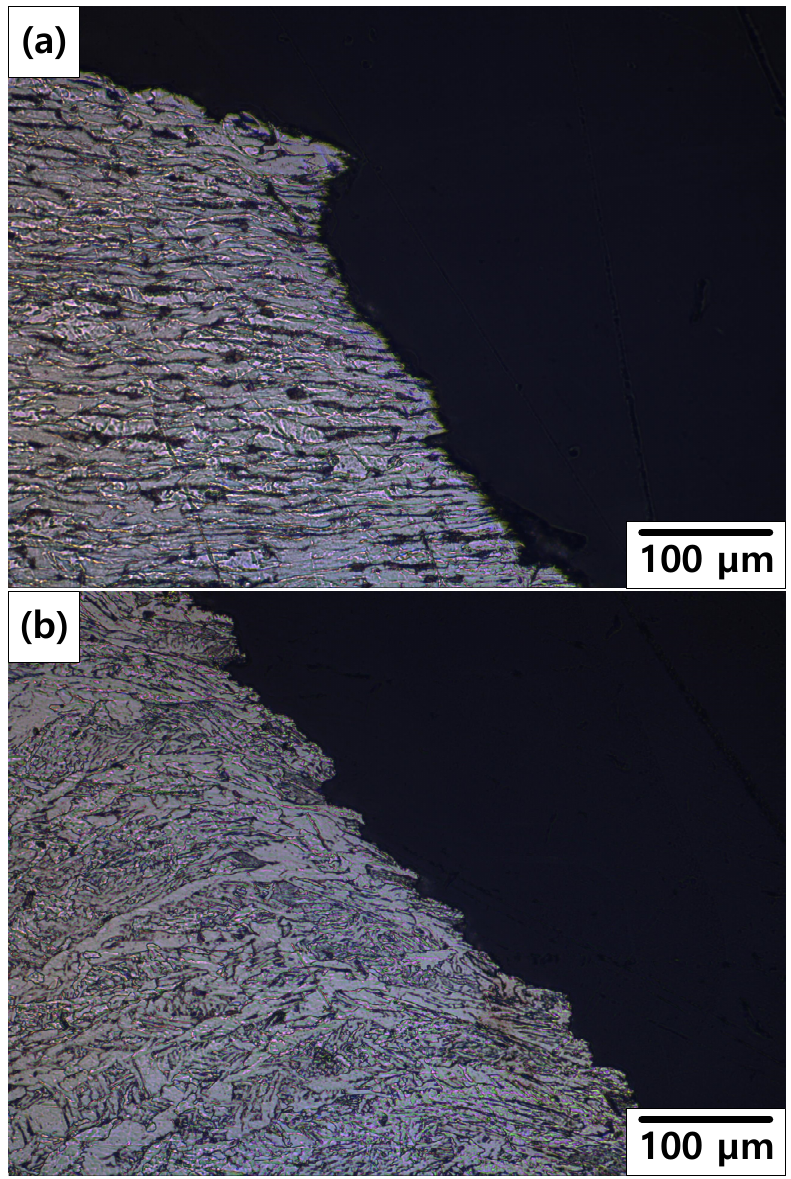
Figure 13. OM images of the cross section of the fracture fronts: ( a ) 10% reduction specimen and ( b ) 50% reduction specimen.